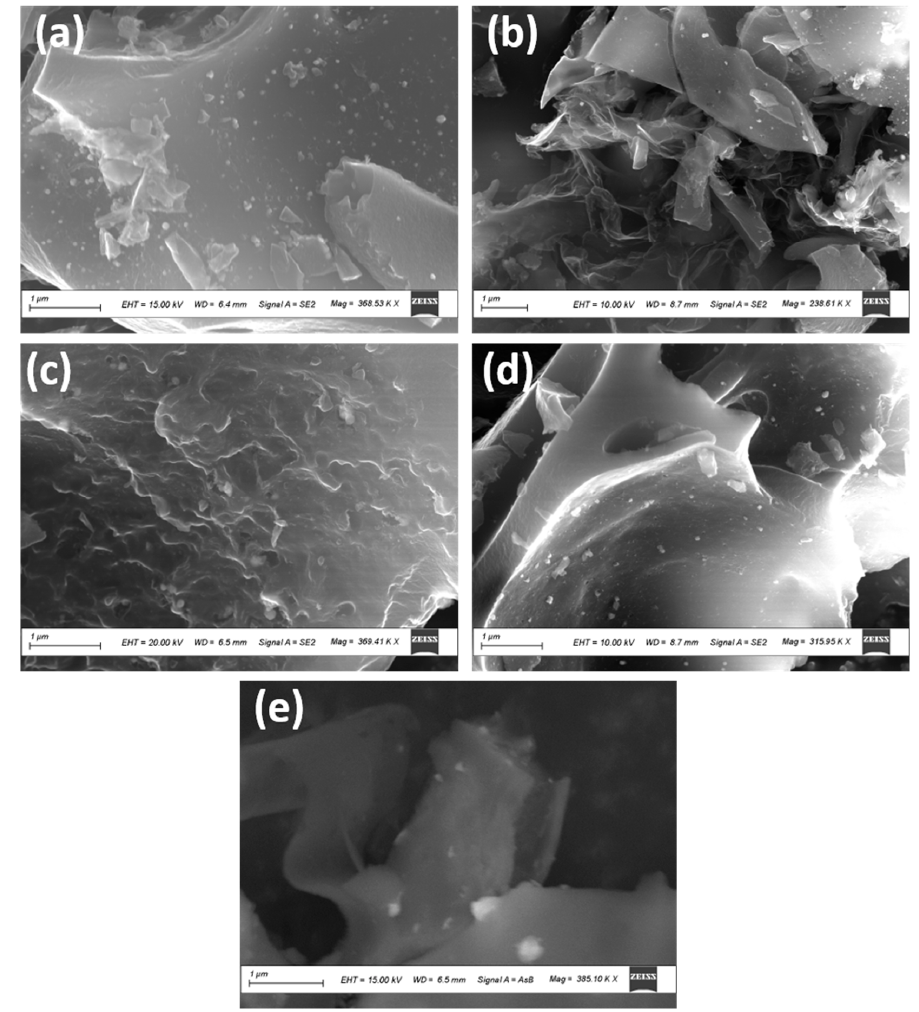
Figure 5. SEM images of samples ( a ) NiMo1/AC, ( b ) NiMo2/AC, ( c ) NiMo3/AC, ( d ) NiMo4/AC, and ( e ) NiMo5/AC.